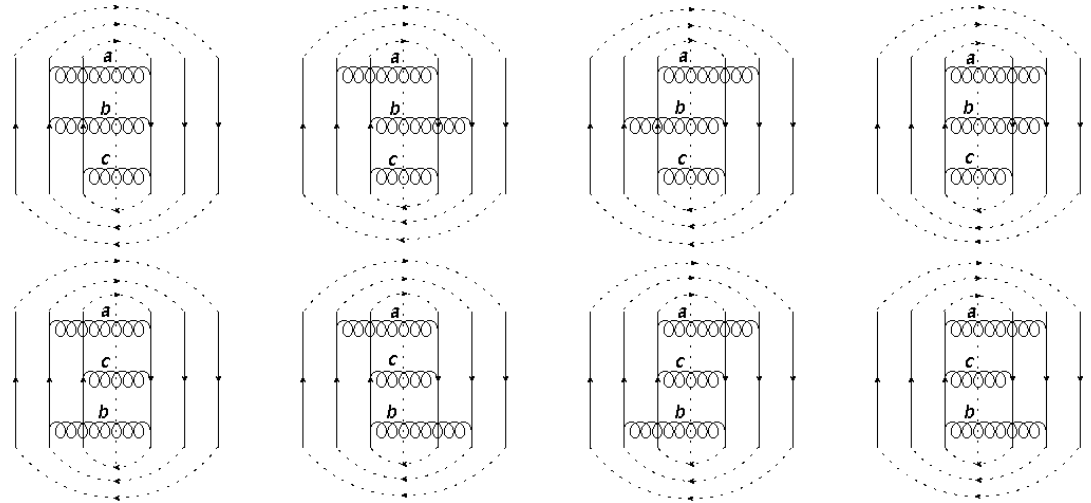
Figure 10 . Some of the contributions with two o(cid:11)-diagonal and one diagonal gluon that contribute to the k = 3-gluon radiation spectrum from N = 3 sources. The color factor (A.2) for diagrams in the top row is twice as large as the color factor (A.3) for those in the bottom